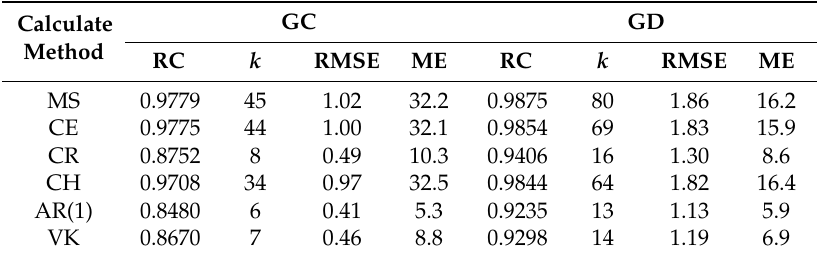
Table 3. Recession constants (RC), mean residence time ( k ), root mean square error (RMSE), and measuring efficiency (ME) of the GC and GD